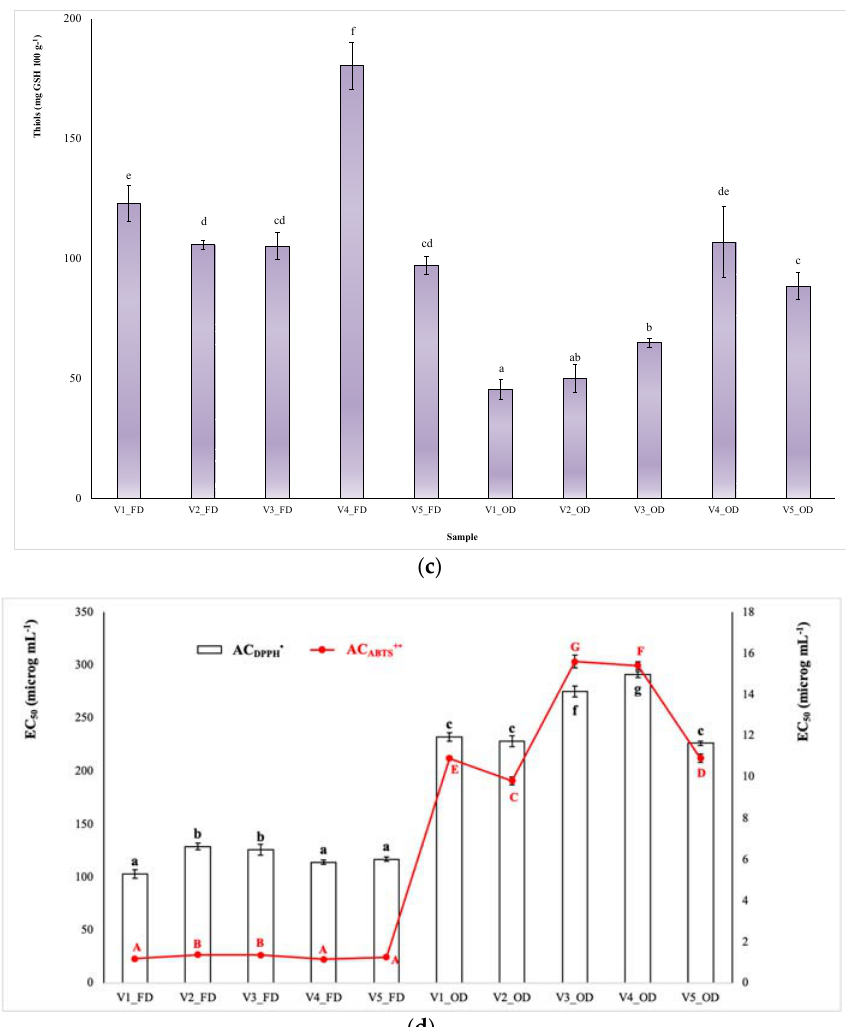
Figure 4. Influence of genotype and drying treatment on the phytochemical composition of samples